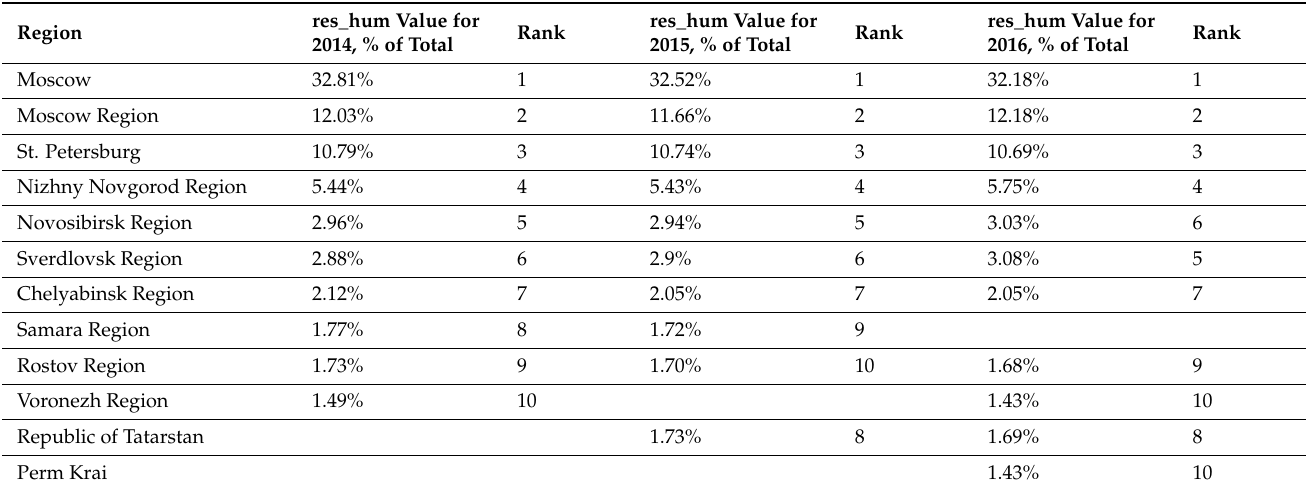
Table 7. Top 10 regions with the highest res_hum indicator for 2014–2016.